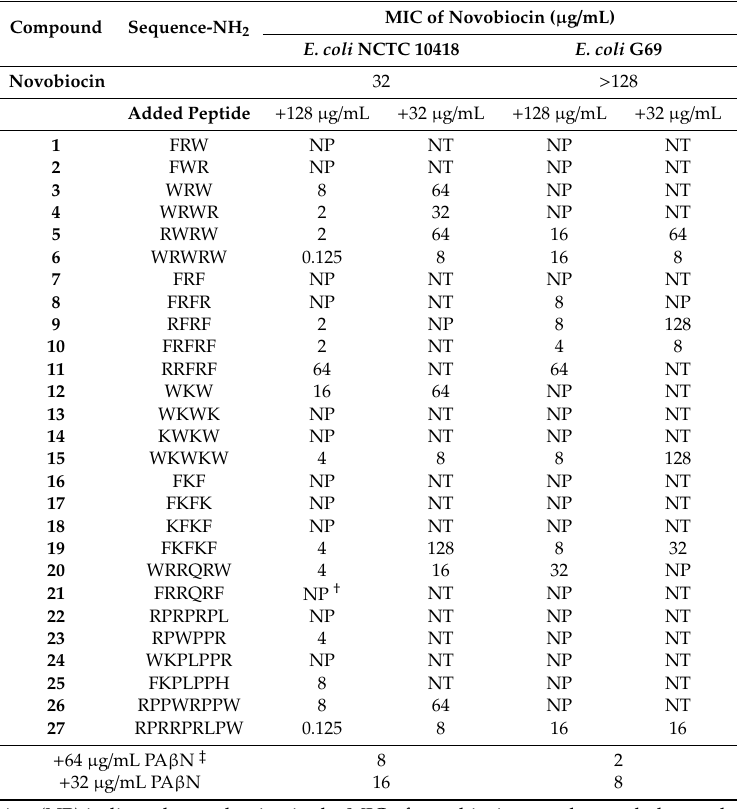
Table 1. Antimicrobial activity of novobiocin in the presence of potentiating peptides at fixed concentrations against susceptible E. coli 10,418 and multi-drug resistant clinical isolate E. coli G69. A potentiation assay for novobiocin was also performed in the presence of 32 µ g / mL of RND e ffl ux pump inhibitor PA β N. All tests were performed in